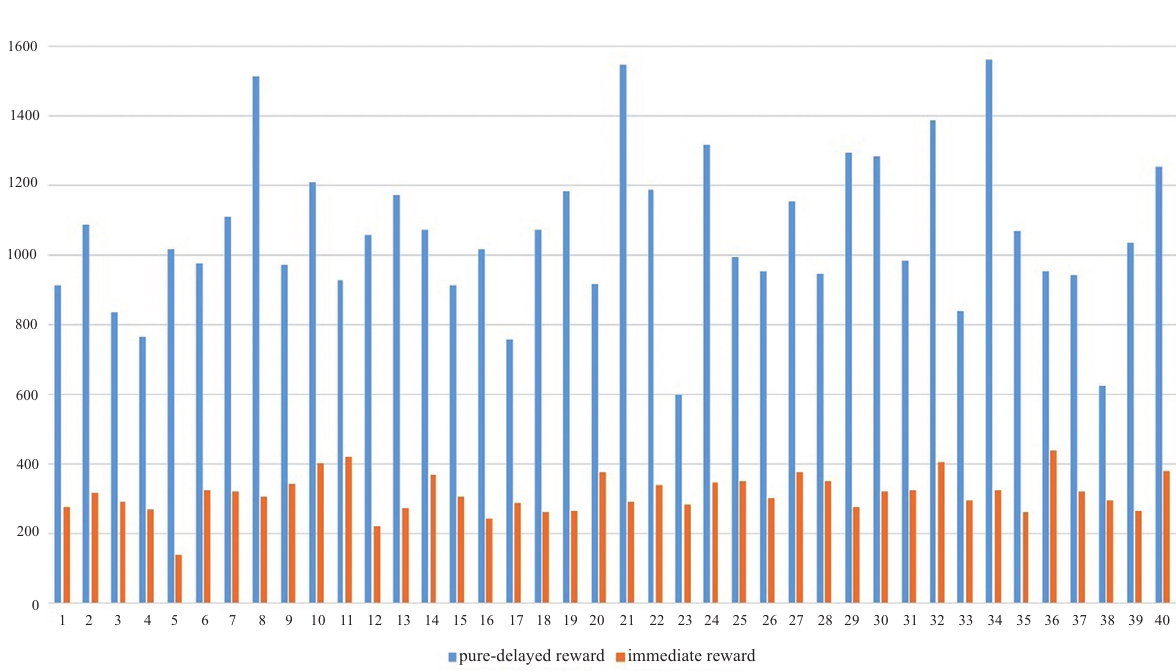
Fig. 3. Distribution of the number of training steps for two reward schemes when 𝑛 =